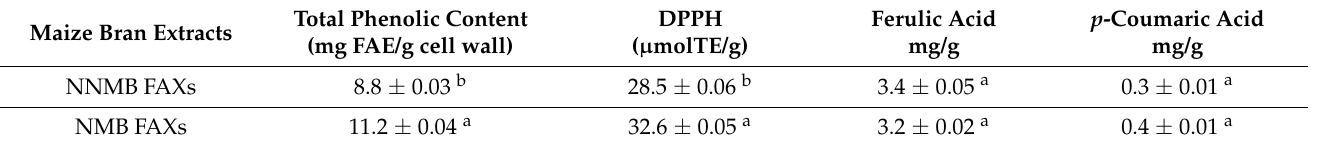
Table 2. Total phenolic content, phenolic acid contents and antioxidant activity (DPPH) of NMB and NNMB